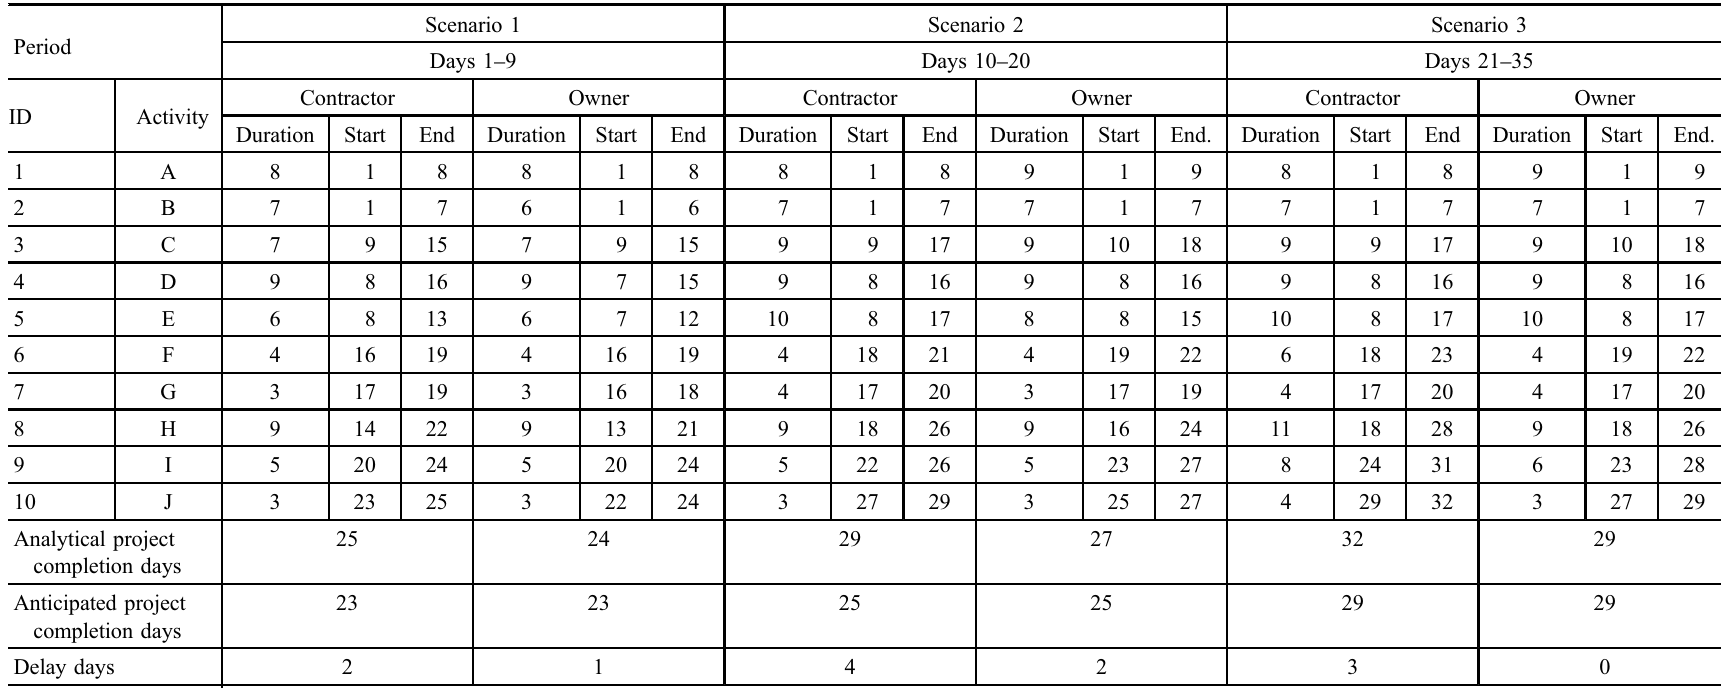
Table 5. Analysis results in the computer-based IDT method